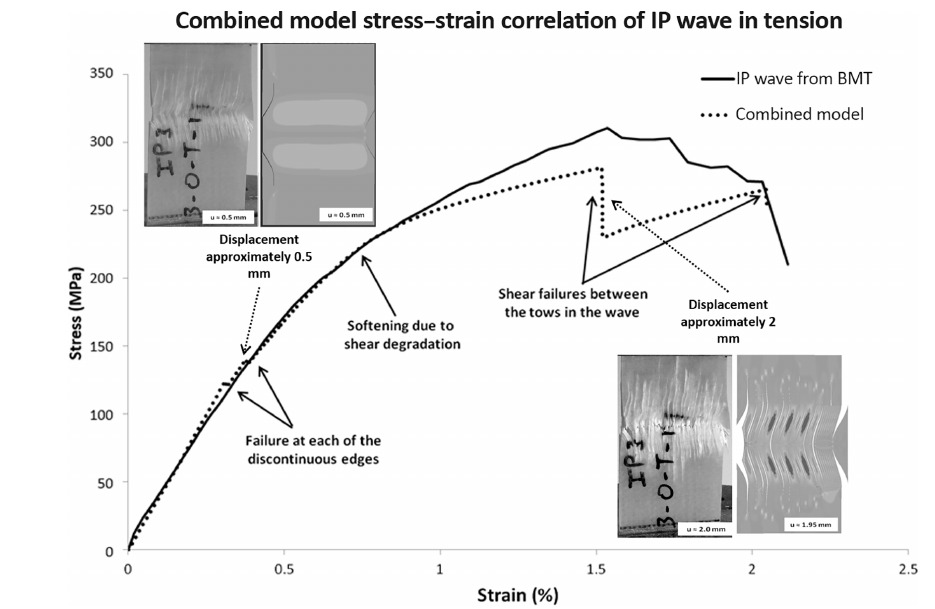
Figure 9. Comparison of damage at displacements of approximately 0.5 and 2mm between experimental (above) and analytical (below), showing onset to final damage from left to right, with points and damage progression identified on the resulting stress–strain curve.